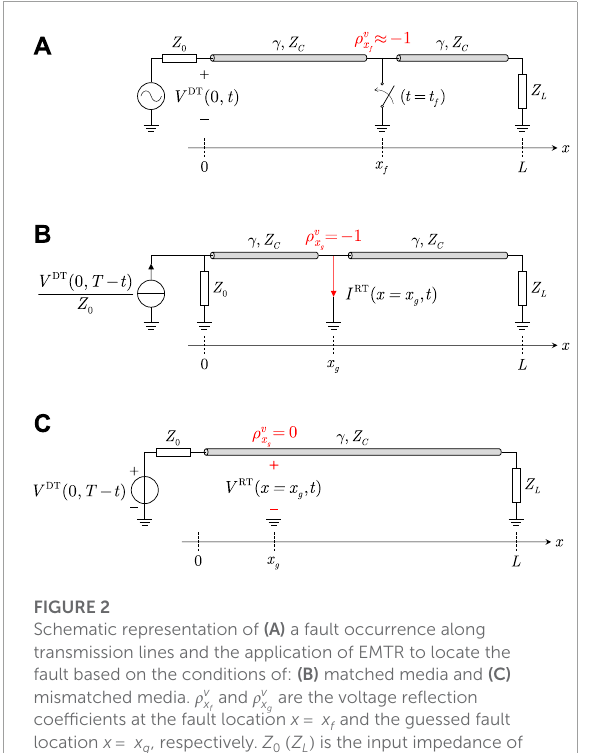
FIGURE 2 Schematic representation of (A) a fault occurrence along transmission lines and the application of EMTR to locate the fault based on the conditions of: (B) matched media and (C) mismatched media. ρ v x and ρ v x are the voltage reflection f g coefficients at the fault location x = x f and the guessed fault location x = x g , respectively. Z 0 ( Z L ) is the input impedance of terminal power equipment [adapted from (Wang et al. (2022)].